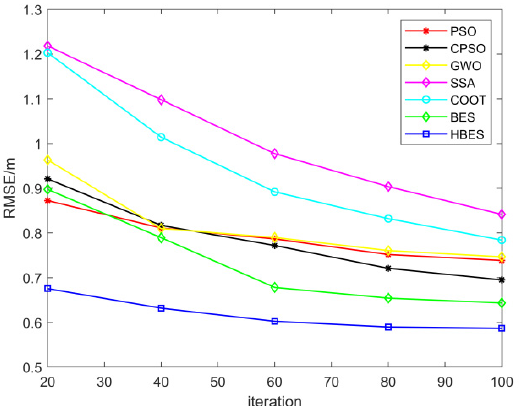
Figure 7. Relationship between RMSE and iteration times.